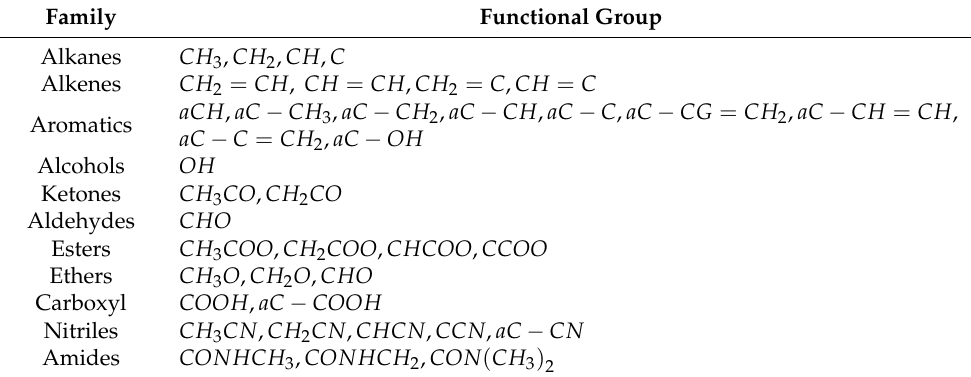
Table A3. The functional groups considered for the solvent molecular design.